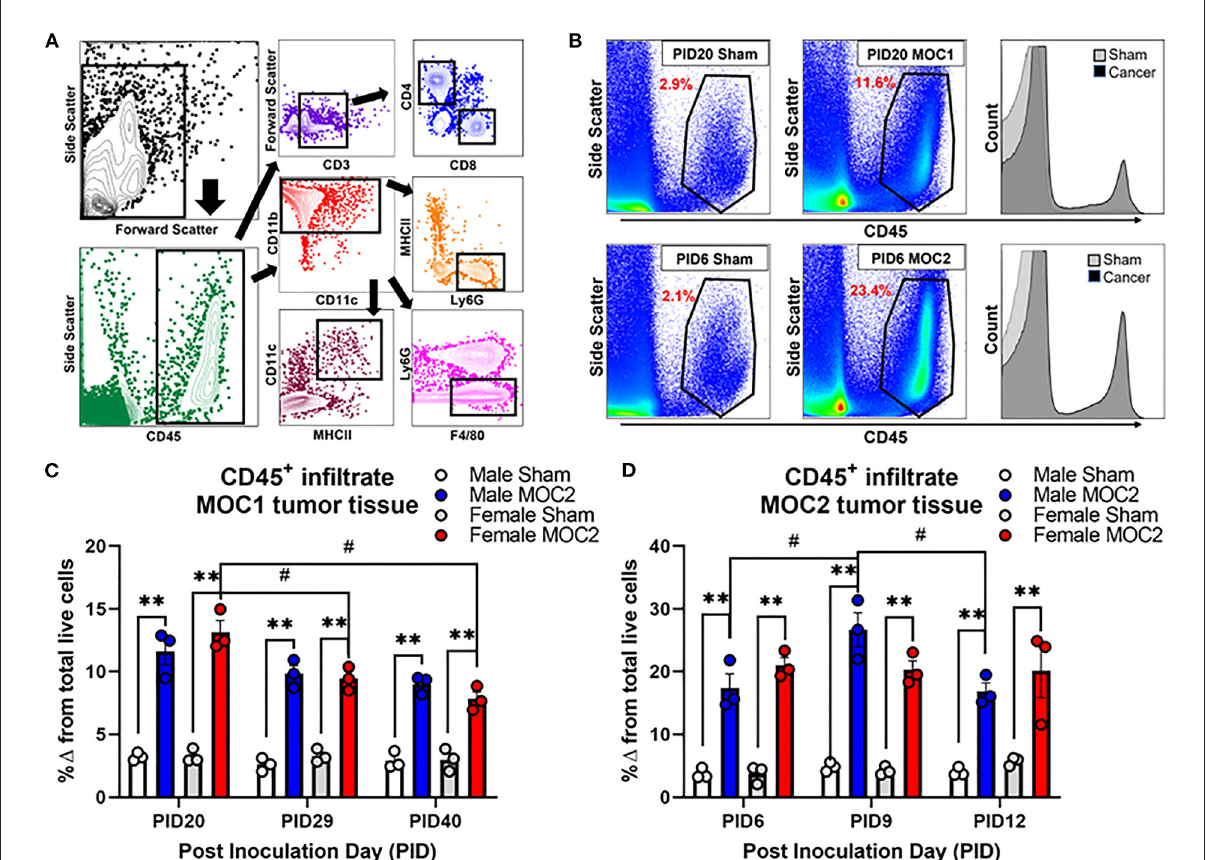
FIGURE5 Tumor-associated immune infiltrate during tumor progression. Immune infiltrate in tongue tissue was measured in male and female sham, MOC1 and MOC2 tumor-bearing mice during tumorigenesis. (A) Analytical cytometric gating strategy used to characterize immune subpopulations. Following viability gating to isolate live cells (not shown), CD45 + cells were gated into either CD3 + /- lymphocytes or CD11b + myeloid cells. CD3 + cells were further gated into CD4T helper or CD8 cytotoxic T cells. CD3- cells were further gated into CD19 + B cells or NK1.1 + NK cells. The CD11b + leukocytes were gated into MHCII + CD11c + dendritic cells, Ly6G-F4/80 + macrophages, or CD11b + Ly6g + neutrophils. (B) Representative scatter plots showing CD45 + immune cells in tongue tissue from sham and MOC1 tumors at PID20 as well as in sham and MOC2 tumors at PID6. Histograms demonstrate the increase in CD45 + counts in tumor tongue tissue compared to sham. CD45 + immune infiltrate was quantified by analytical cytometry at three different time points in the MOC1 (C) and MOC2 (D) models. N =